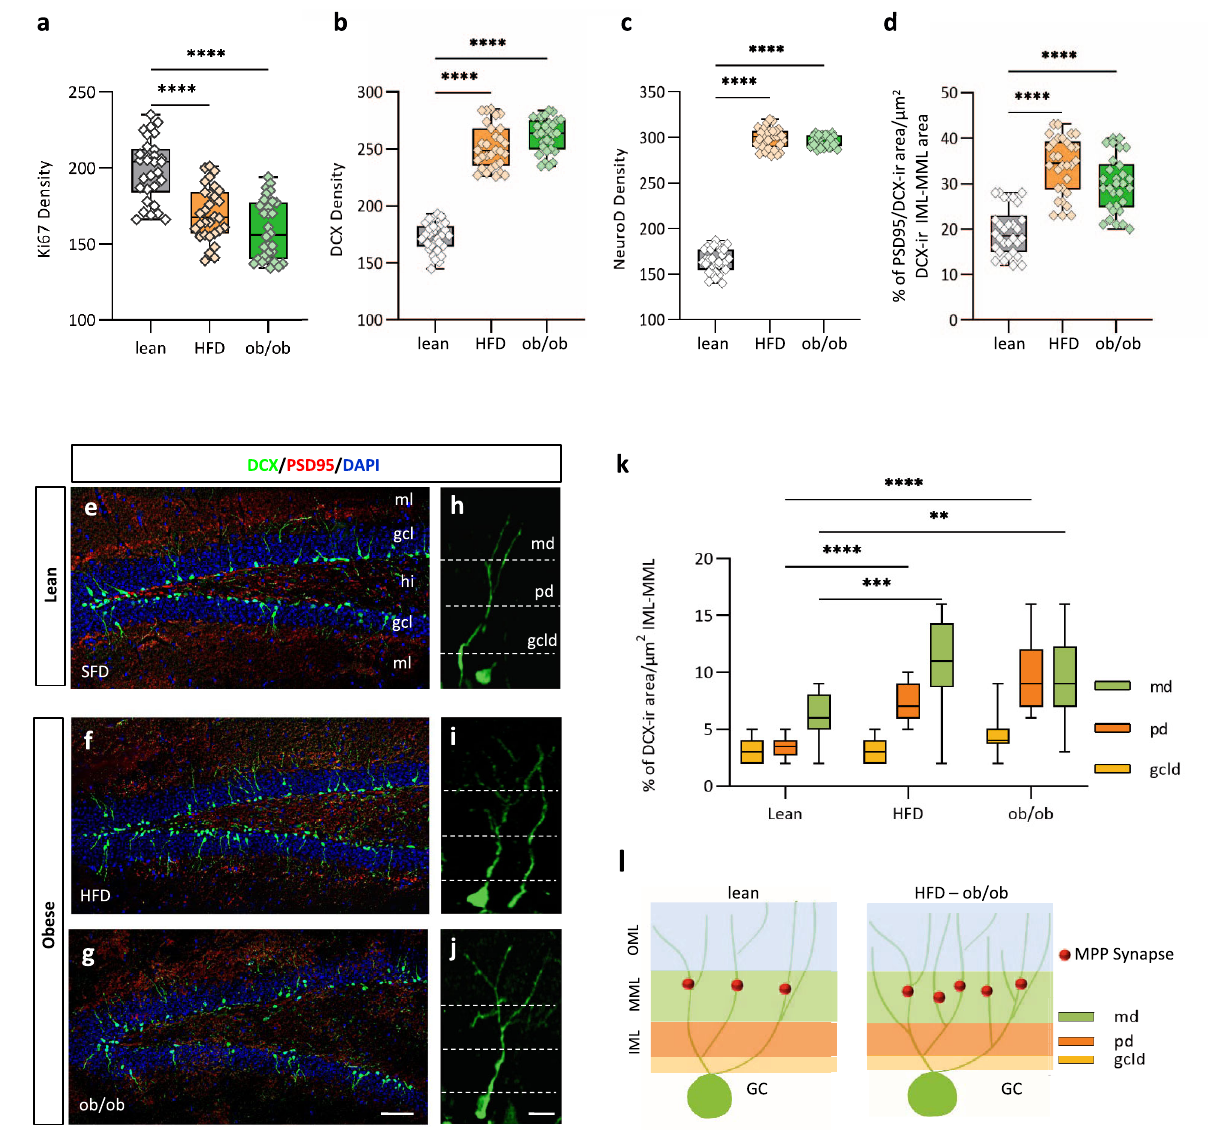
Fig. 3 Adult hippocampal neurogenesis is altered in the DG of obese mice. a − c Graphs showing the NPCs proliferative and differentiative ef fi ciency by mean of quantitative stereological counting of Ki67-ir ( a ), or DCX-ir ( b ) or NeuroD-ir ( c ) cell pro fi les in the DG of lean and obese (ob/ob and HFD) mice. Graphs show box-whisker plots (including minima, maxima, and median values, lower and upper quartiles) with single values. Data are from n = 30 slices in n = 6 mice per group; ANOVA test with Bonferroni post hoc, **** p < 0.0001, F = 47.48). d Graph showing dendritic development and complexity of DCX-positive neurons by quanti fi cation of PSD95/DCX-ir colocalizing area vs DCX-ir area in the inner (IML) and medial (MML) molecular layers of DG in lean and obese mice. Graphs show box-whisker plots (including minima, maxima, and median values, lower and upper quartiles) with single values. Data are mean of the percentage± percentage of SEM from n = 30 slices in n = 6 mice per group; ANOVA test with Bonferroni post hoc, **** p < 0.0001, F = 47.48). e − g Confocal images of DCX/PSD95/DAPI immunolabeled of the dentate gyrus (DG) showing the adult-born granule cells DCX-ir (green) which constitute a subpopulation of the granular cell layer with higher PSD95-ir (red) postsynaptic density in the IML and MML of obese ( f , g ) and lean ( e ) mice as demonstrated by the high degree of colocalizing DCX/PSD95-ir puncta (yellow-orange) as an index of functional integration of the adult-born granule cells in the DG revealed by the high-density percentage of PSD95/DCX-ir colocalizing area vs DCX-ir area in the ML of obese mice (lean: 19.5% ± 0.9%, HFD: 34.2% ± 1.1%, ob/ob: 29.8% ± 1.1%. n = 30 slices in n = 6 mice per group; ANOVA test with Bonferroni post hoc, **** p < 0.0001, F = 47.48) (scale bar: 100 µ m). Immunolabeling was repeated n = 3 times independently in sections from n = 6 mice per group, with similar results. h − j High-power images of typical DCX-ir adult-born granule cells demonstrating the development, length, and branching complexity of DCX-positive neurons in obese than in lean mice (scale bar: 10 µ m). k Percentage of basal, proximal, and medial dendrites revealed by PSD95/DCX-ir vs DCX-ir colocalizing area in the respective GCL, IML, and MML (ML) were also signi fi cantly different between DG of obese and lean mice. Two-way ANOVA with Tukey post hoc, ** p < 0.01, *** p < 0.001, **** p < 0.0001. Data are mean of the percentage± percentage of SEM from n = 30 slices in n = 6 mice per group: Immunolabeling was repeated n = 3 times independently in sections from n = 6 mice per group, with similar results. l Schematic representation of the cytoarchitectonic organization of the molecular layer (ML) in DG of lean and obese, HFD and ob/ob, mice. GCL: granular cell layer, IML: inner molecular layer, MML: medial molecular layer, GC: granular cell, md: medial dendrites, pd: proximal dendrite, gcld: granular cell layer dendrite. The box plots elements are: center line, median (Q2); square symbol, mean; box limits, 25th (Q1) − 75th (Q3) percentiles; whisker length is determined by the outermost data points. Source data are provided as a Source Data fi